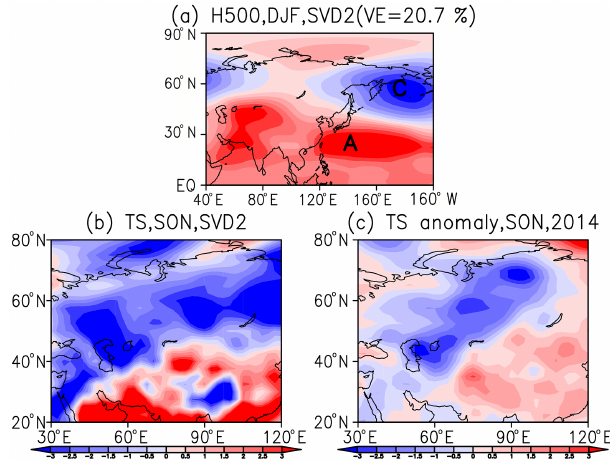
Figure 10. Heterogeneous correlation map of the second SVD mode for detrended and normalized (a) H 500 during DJF and (b) T s during SON 1979–2014, as well as (c) the T s anomalies during SON 2014. Letters A and C in panel (a) represent anticyclone and cy- clone,